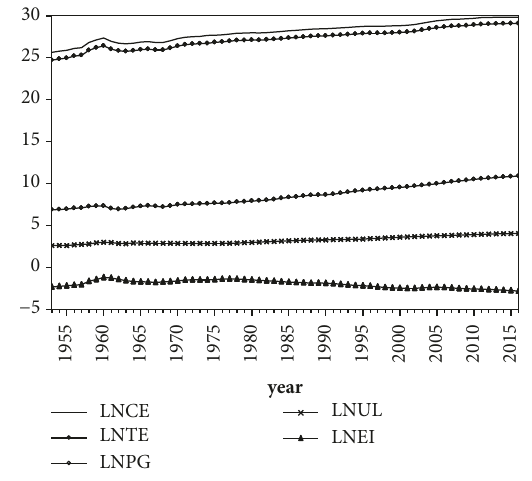
Figure 3: Times histories of level